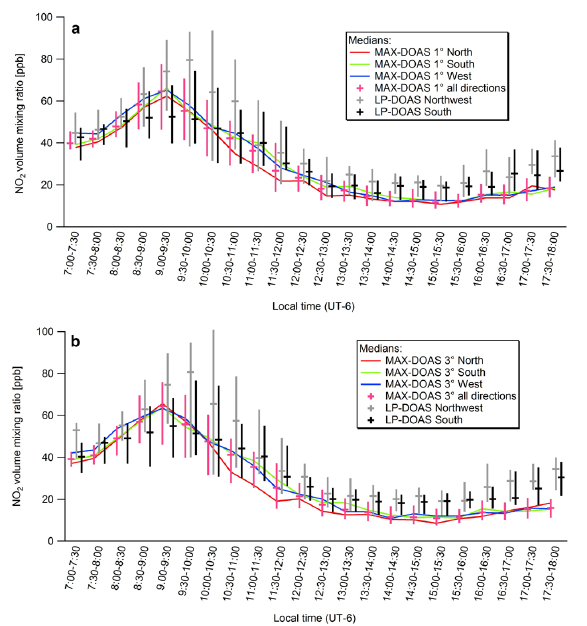
Fig. 8. Median diurnal profile (23 days) of NO 2 mixing ratios mea- sured by MAX-DOAS in three directions and by LP-DOAS in two directions, comparing MAX-DOAS data from (a) 1 ◦ and (b) 3 ◦ el- evation angle as whiskers (crosses indicate medians; vertical exten- sions the 25 and 75 percentiles of the values). The lines are the median values for the different MAX-DOAS